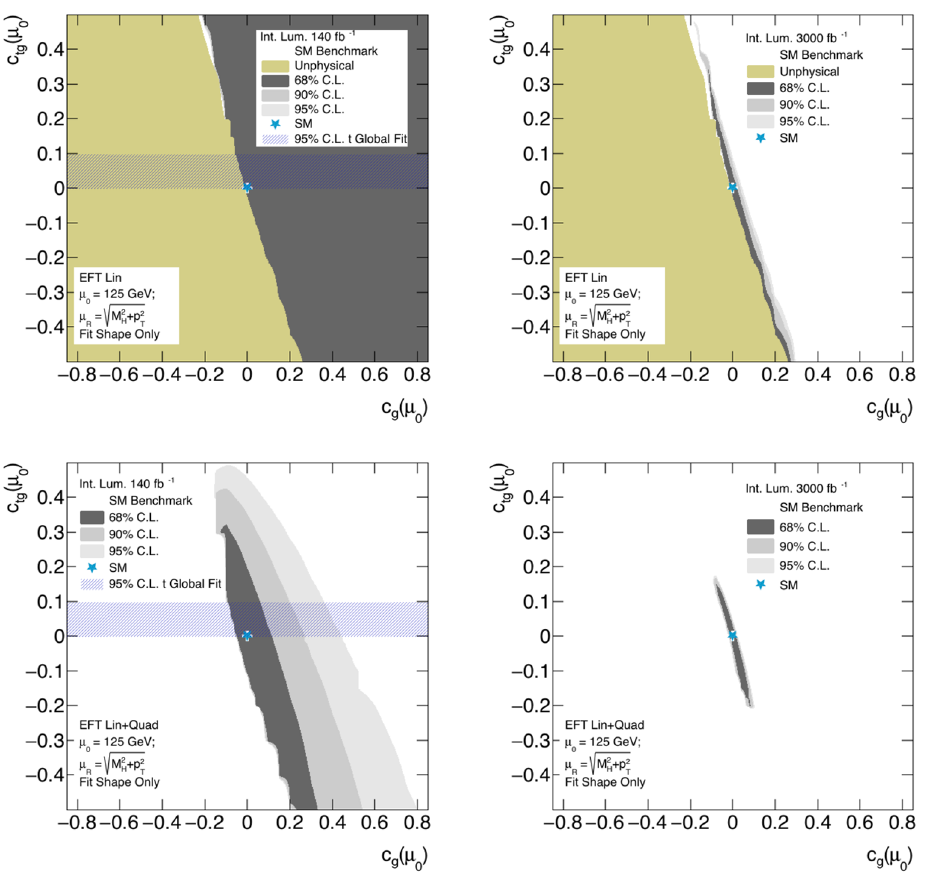
Figure 8. Constraints on the c g and c tg coefficients at 68% (dark grey), 90% (mid grey) and 95% (light grey) C.L. obtained from the fit to the spectrum shape on 200 < p H < 2000 GeV with 140 fb − 1 T (left panels) and 3000 fb − 1 (right panels) for the linear (top panels) and with the addition of the quadratic terms (bottom panels). These constraints are obtained by including a free normalisation term in the fit and are therefore only sensitive to the spectrum shape. The SM value is indicated by the blue star and the best fit value by the white marker. The shaded horizontal strip indicates the 95% C.L. interval for c tg from the top quark fit of ref. [71] translated to our definition of c tg ( µ 0 ) . The region shown in colour and labelled “unphysical” in the fits with only SMEFT linear terms